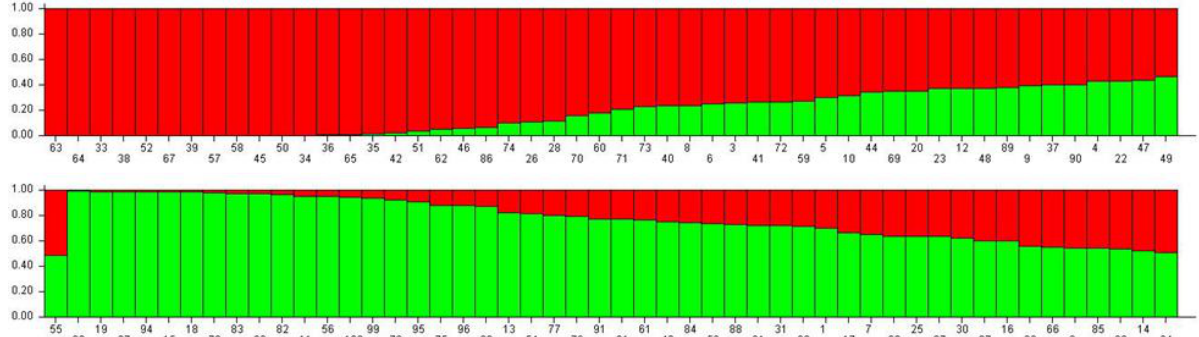
Figure 5. Inferred population structure of Dyera polyphylla based on 100 individuals and 252 loci. A key to the individual samples used in this analysis is provided in the